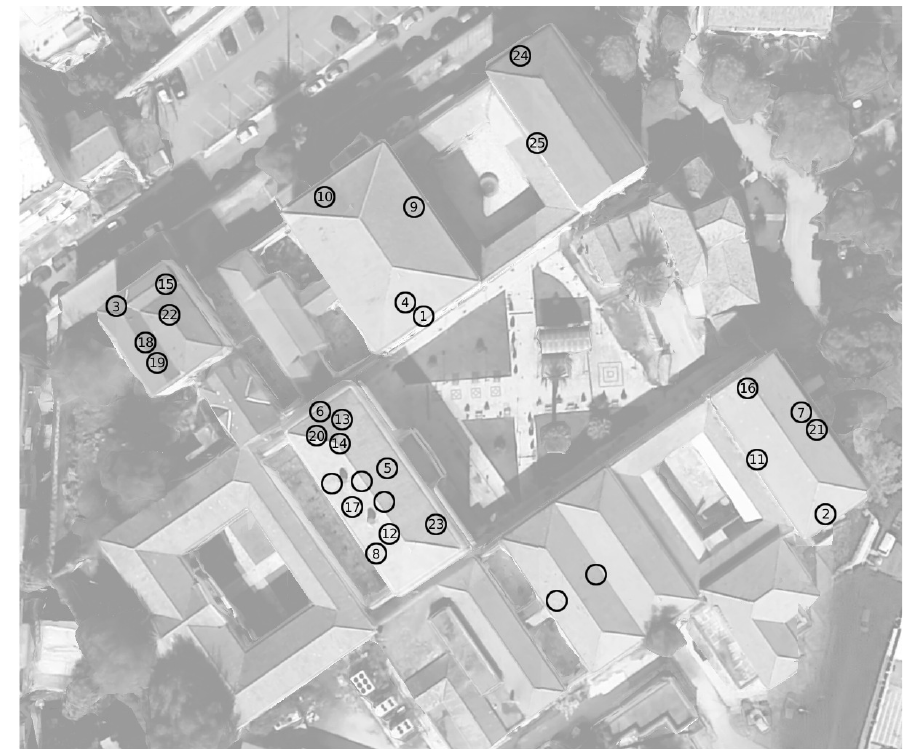
Figure 2. The positions of CaBIUs’ nodes from a satellite view, indicated by circles. The numbers are the corresponding node’s ID. In the topology instance under consideration, the IDs of the nodes, which were not installed, have been